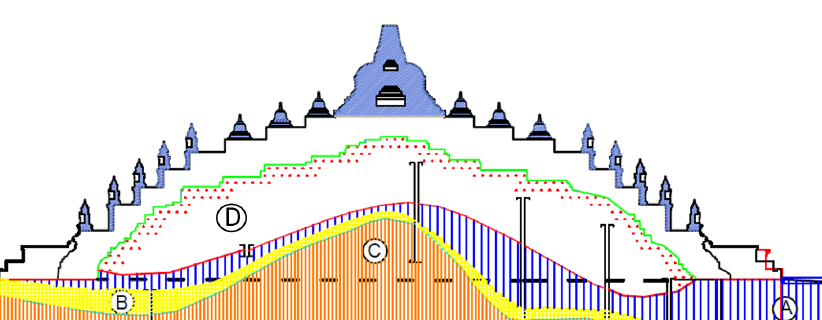
Figure 5. The CAD drawing of the foundation of Borobudur Temple is based on the UNESCO boring survey. From A to D in the photo: ( A ) andesite, ( B ) foam with andesite, ( C ) soft volcanic tuff, and ( D ) andesite with stone chips.